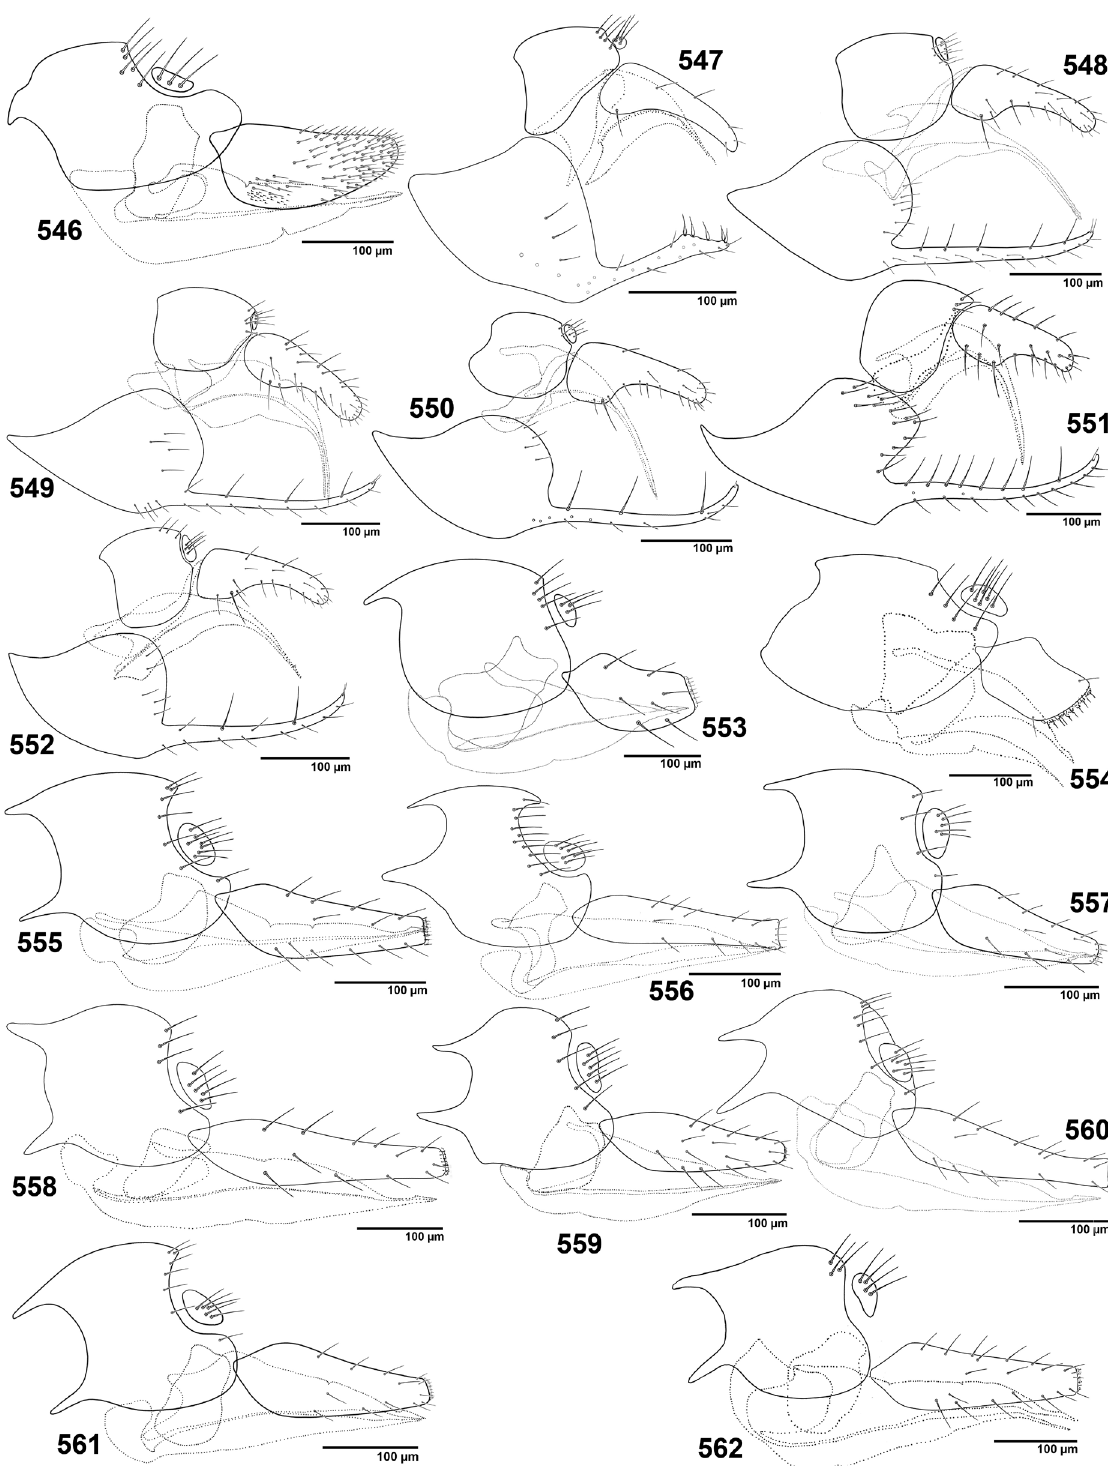
Figs 546–562. Lateral aspect of ♀ genitalia: 546 . Areopraon lepelleyi . 547 . Betuloxys hortorum . 548 . Binodoxys acalephae . 549 . Binodoxys angelicae . 550 . Binodoxys brevicornis . 551 . Binodoxys centaureae . 552 . Binodoxys heraclei . 553 . Diaeretiella rapae . 554 . Diaeretus leucopterus . 555 . Ephedrus cerasicola . 556 . Ephedrus chaitophori . 557 . Ephedrus helleni . 558 . Ephedrus lacertosus . 559 . Ephedrus nacheri . 560 . Ephedrus niger . 561 . Ephedrus persicae . 562 . Ephedrus plagiator